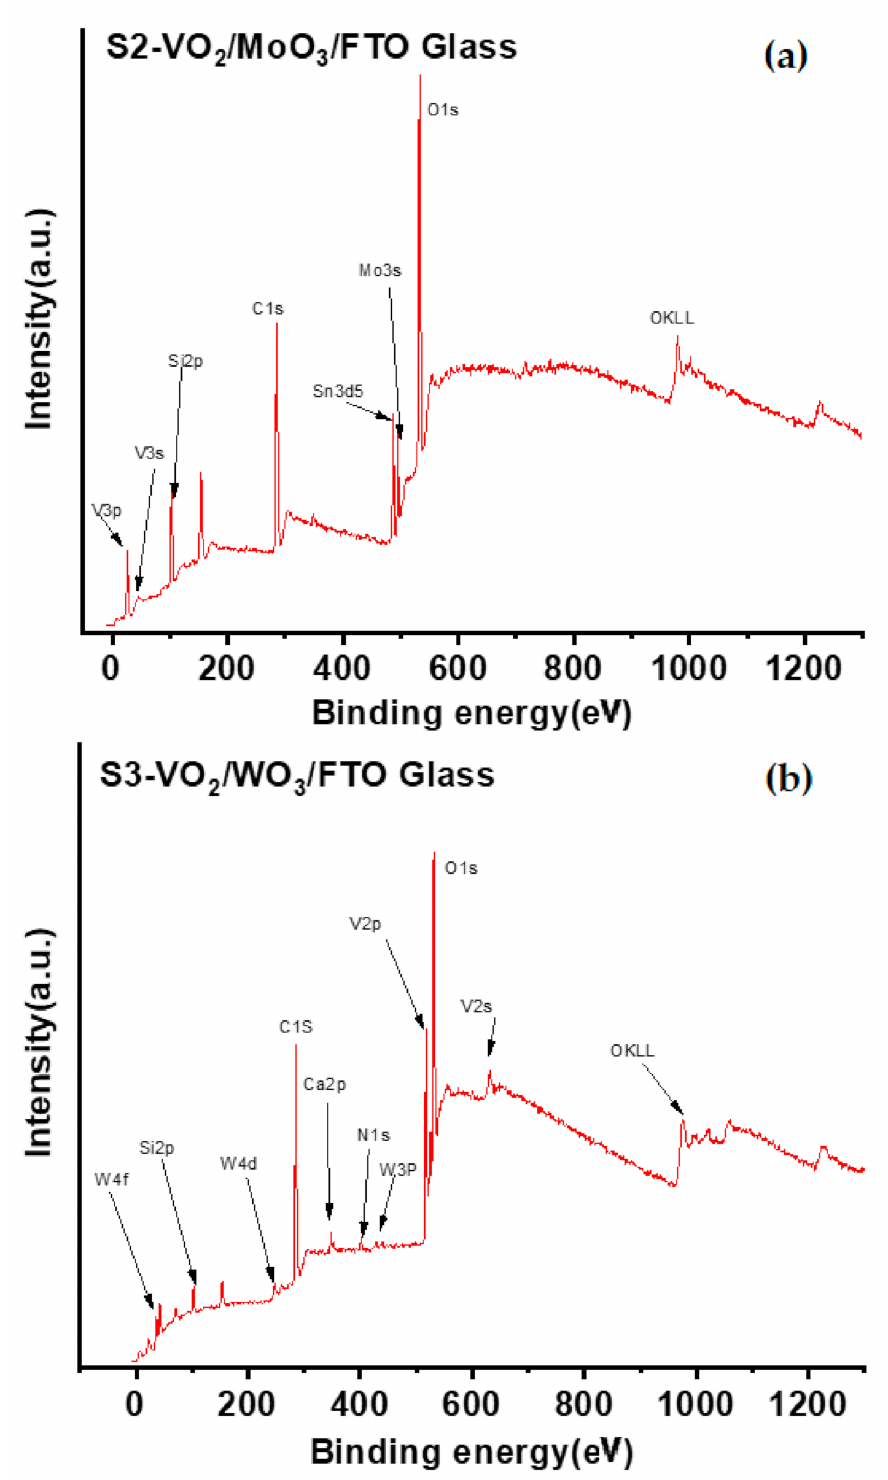
Figure 5. Fast XPS scan of some selected samples: ( a ) S2 and ( b )